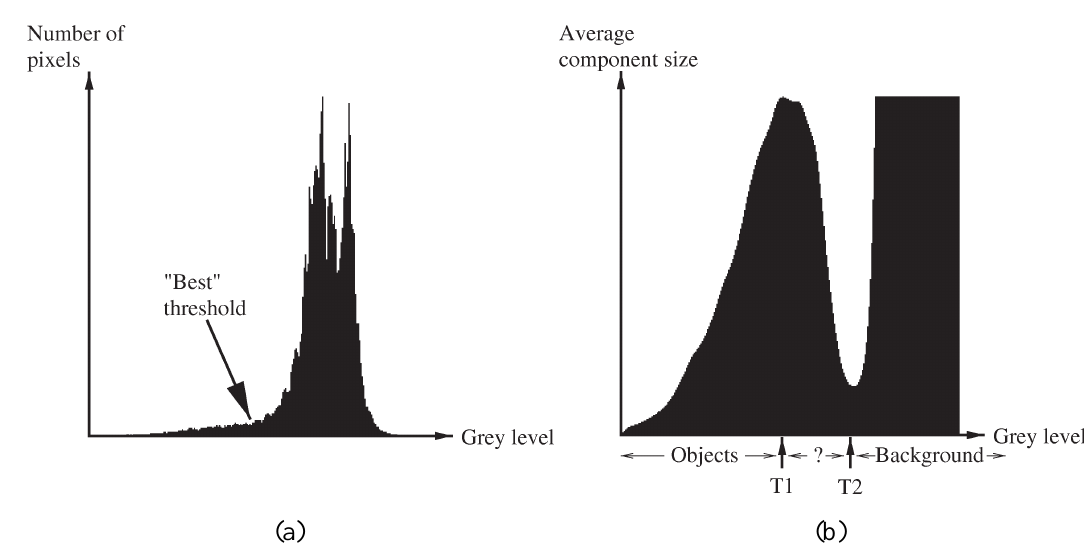
Fig. 2. This figure shows the usefulness of the average component size histogram compared to the ordinary greylevel histogram. (a) Ordinary greylevel histogram of PC1 image. In this histogram it is difficult to find the best threshold level to segment microvessels from background. (b) Average component size histogram. Note that the histogram has been truncated at the greylevel corresponding to the peak of the greylevel histogram. This is done since the average component size will be very large at high